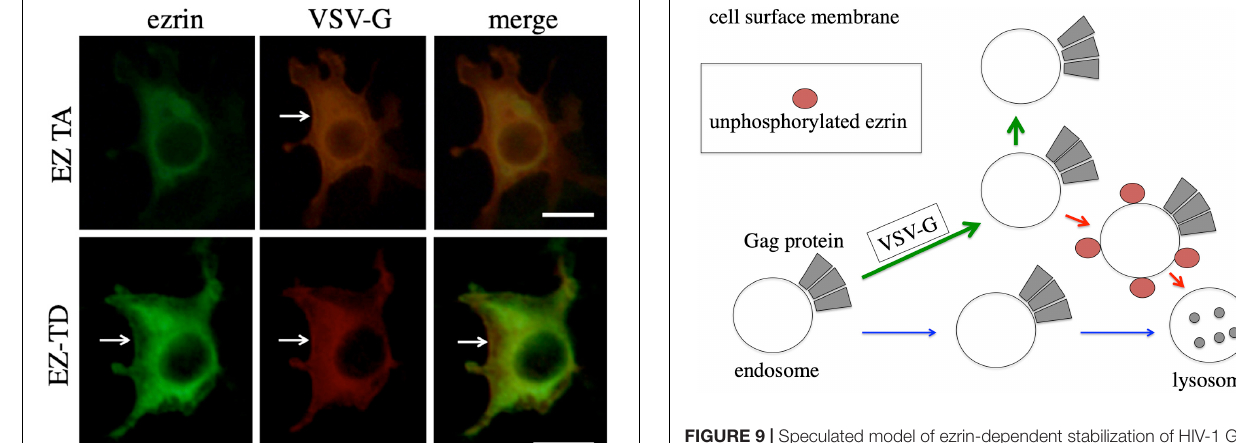
FIGURE 9 | Speculated model of ezrin-dependent stabilization of HIV-1 Gag protein by VSV-G in African green monkey cells. In the absence of VSV-G, HIV-1 Gag protein-associated endosomes are transported to lysosomes, and HIV-1 Gag protein is degraded (blue arrows). In the presence of VSV-G, trafficking of HIV-1 Gag protein-associated endosomes is changed to cell surface (green arrows). Even in the presence of VSV-G,